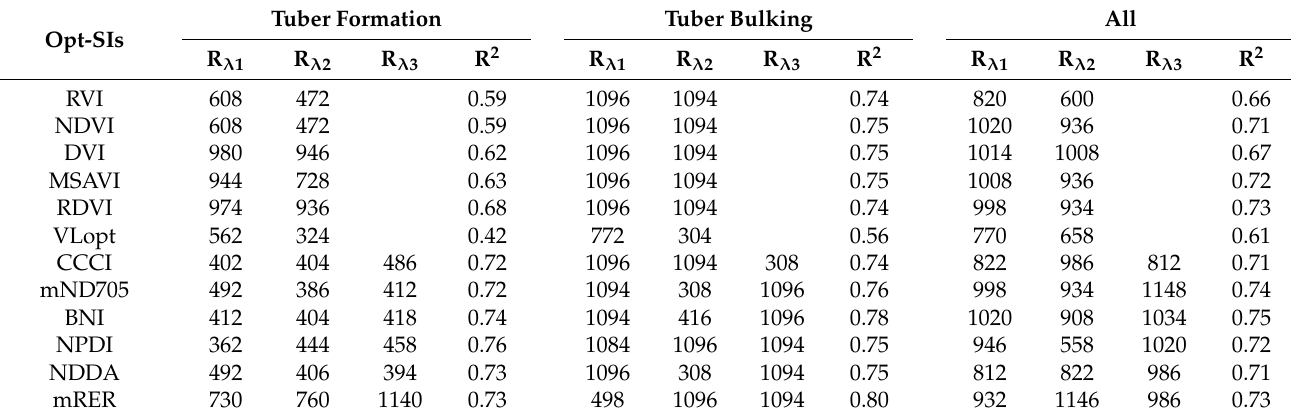
BNI 412 NPDI 362 NDDA